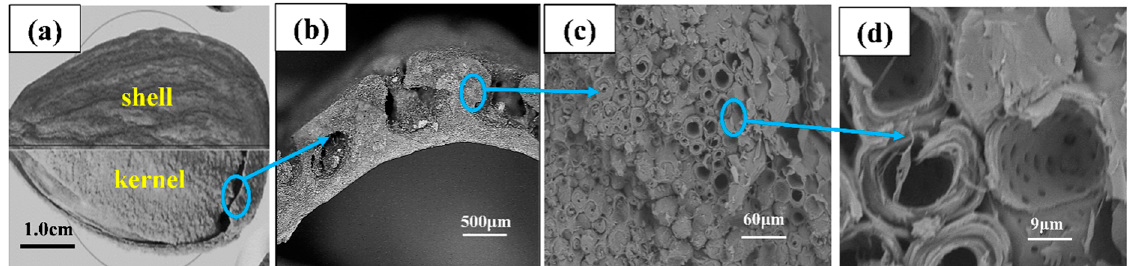
Figure 1. Almond shell micro-topography. ( a ) Overall view; ( b ) Cross-section of shell; ( c ) Dense part of almond shell; ( d ) Hollow ball in the almond shell.